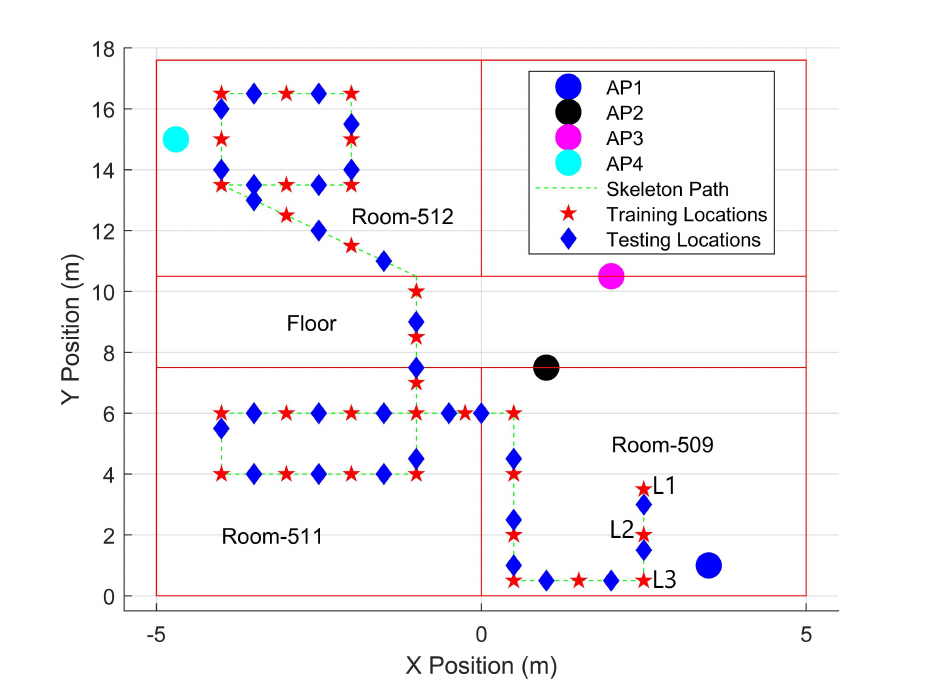
Figure 6. Experiment skeleton map.